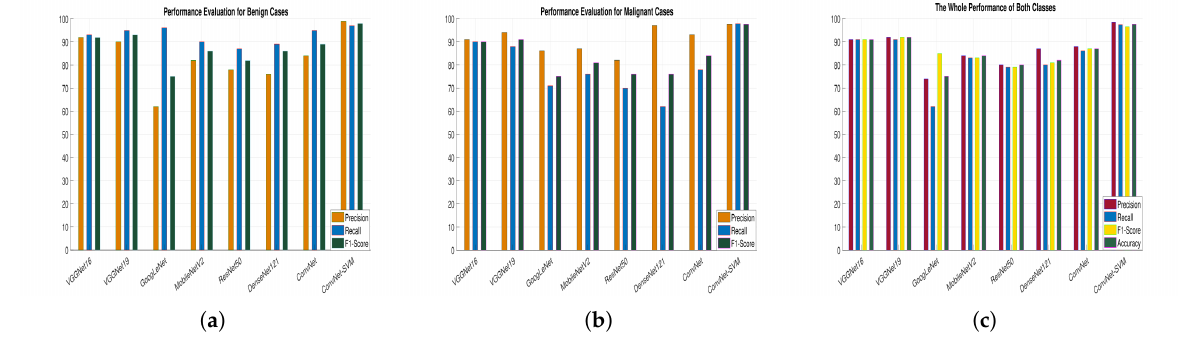
Figure 8. The graphical representation of the results for all comparative experiments: ( a ) Performance analysis for Benign class, ( b ) performance analysis for Malignant class, ( c ) the cumulative performance of both classes.